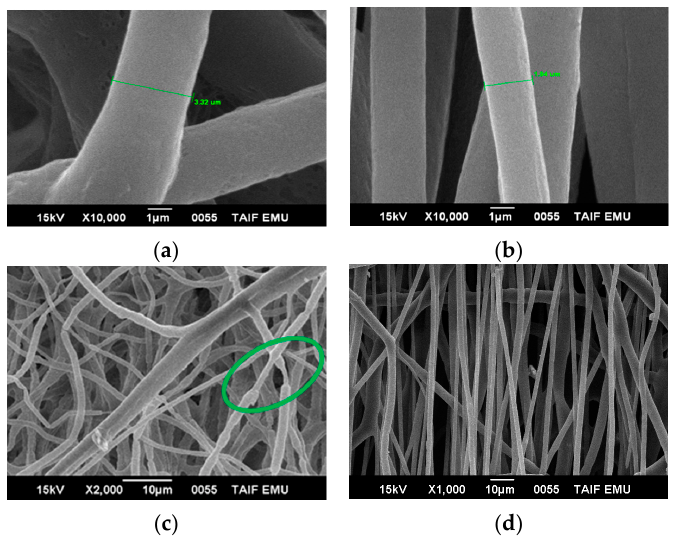
Figure 3. The samples of blend 1 at different scales and speeds were collected on the aluminum foil with the following polymer concentrations, die diameter, applied voltages, CF/DMF ratios, flow rate, and distance between the needle and target: 25 wt %, 1.3 mm, 20 kV, 90:10, 0.185 µm ⋅ h − 1 and 20 cm, ( a , c ) at fixed target (random); ( b , d ) at a rotating drum with a speed of 1100 rpm, respectively. The aligned electrospun fibers of pure PHB (Figure 2) and blend 1 showed no signs of necking